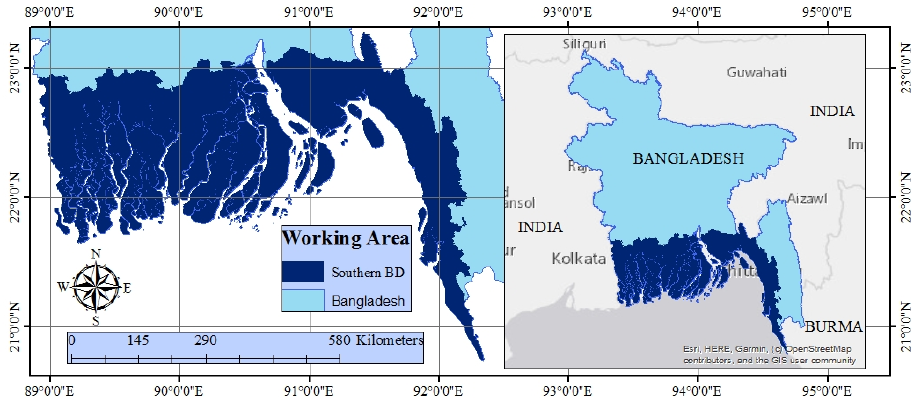
Figure 1. The southern area of Bangladesh for mesoscale modeling analysis.